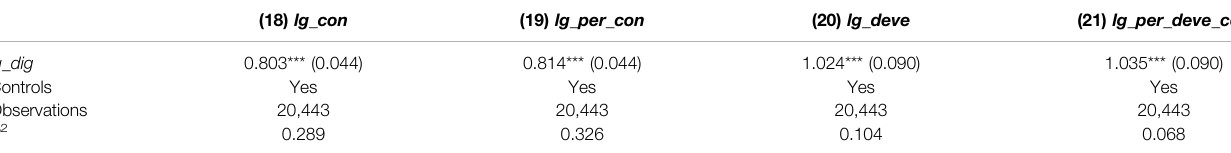
TABLE 5 | Robustness checks: Control Function